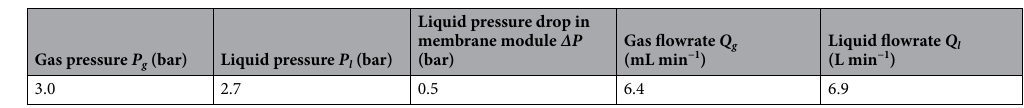
Table 1. Parameters of ADON generation